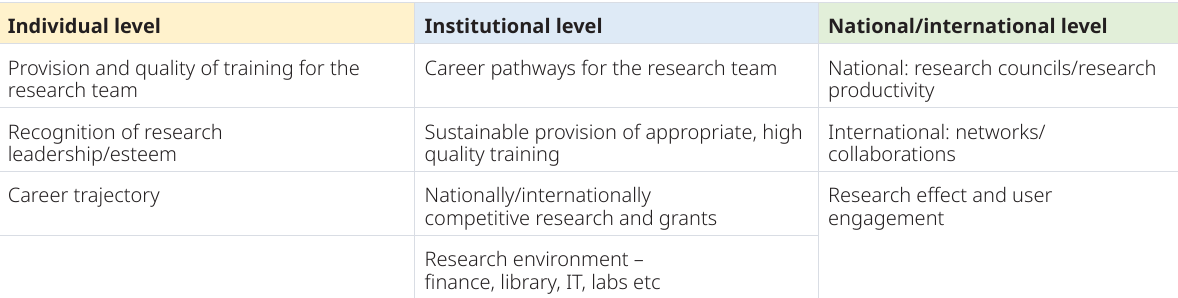
Table 2. Framework for evaluating Research Capacity Strengthening from Khisa et al. , 2019 24